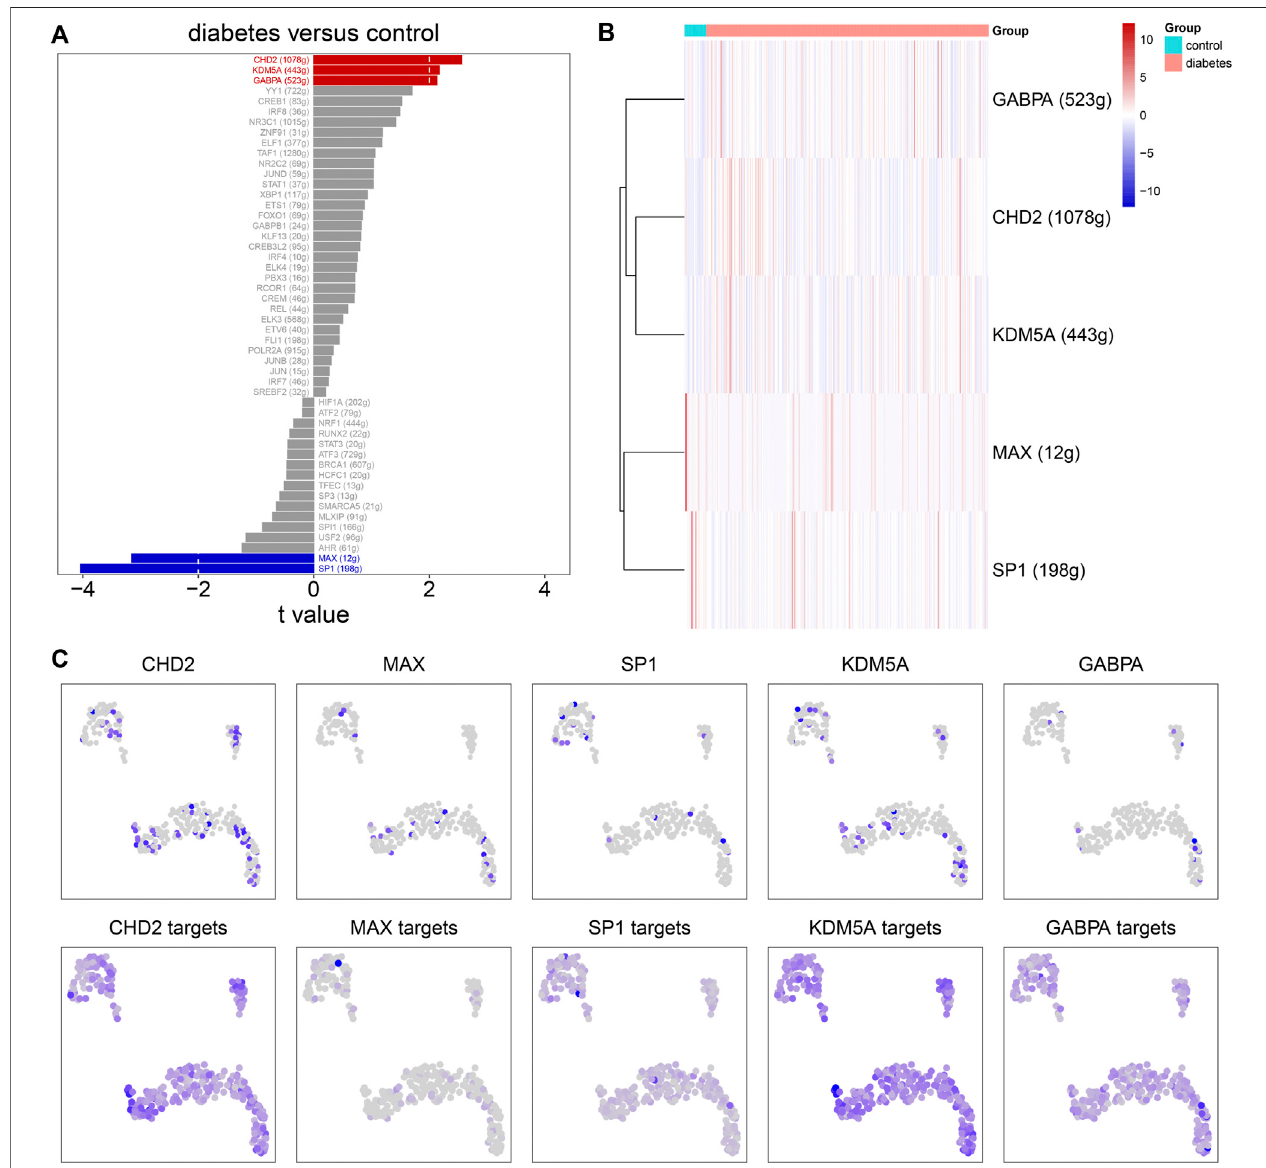
FIGURE 8 | Single-cell regulatory network analysis. (A) The top 50 transcription factors according to the t values by comparing AUC values between diabetic nephropathy and controls. (B) Heat map for the AUC values of the main transcription factors in diabetic kidney specimens compared to controls. (C) The expression levels (upper) and AUC values (bottom) of the main transcription factors in immune